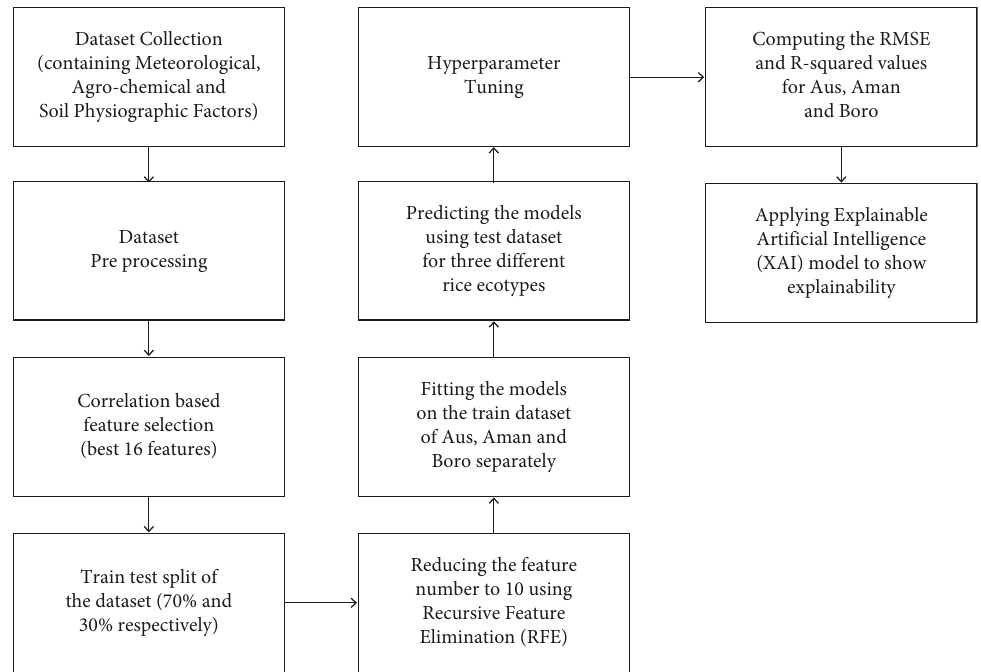
Figure 1: System overview of the proposed yield prediction